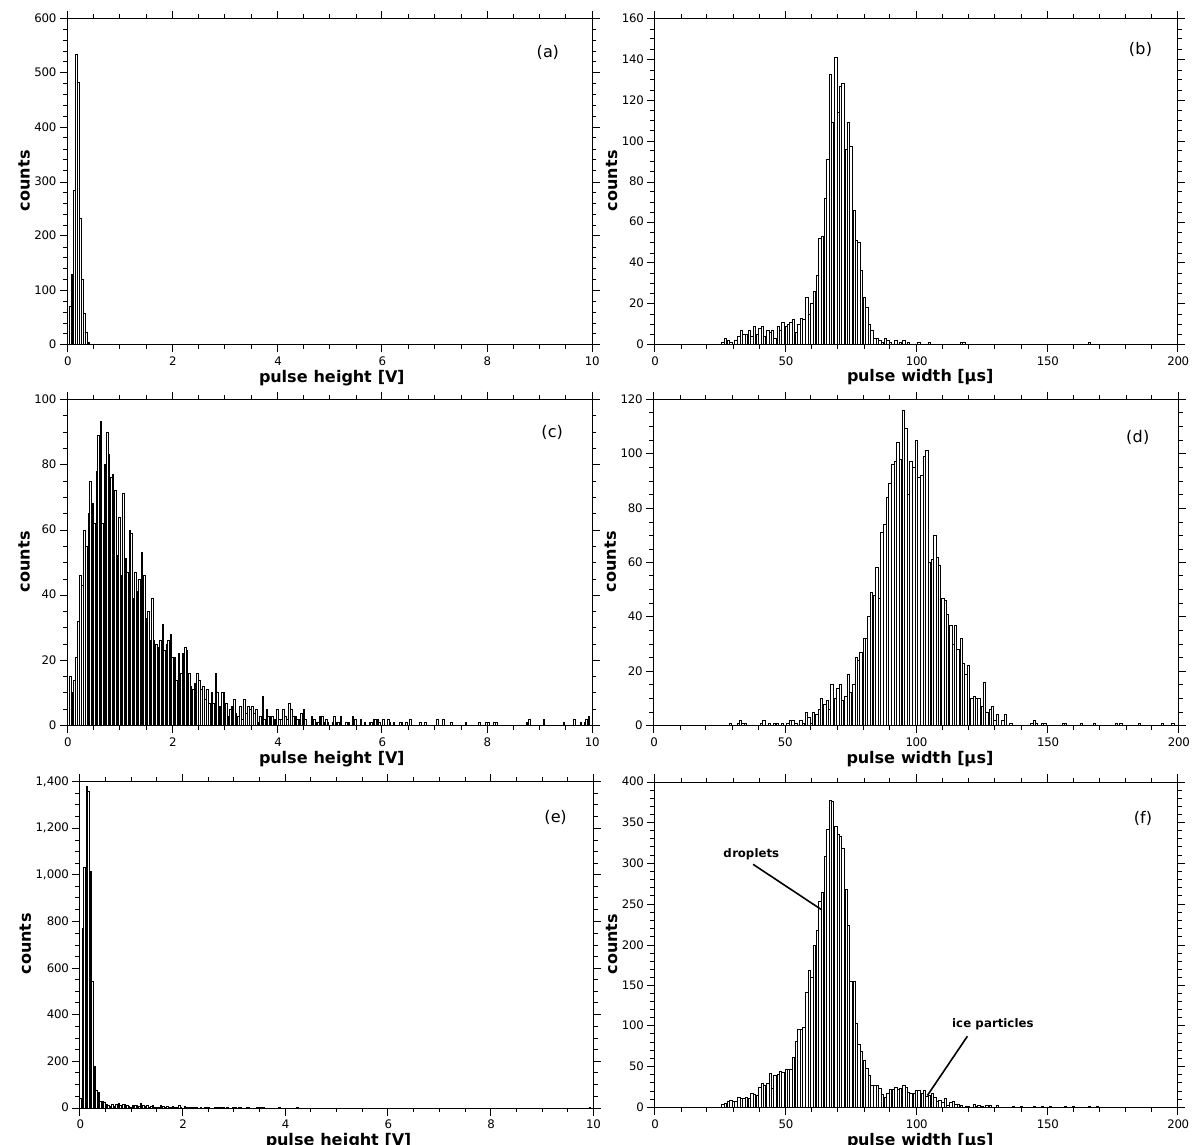
Fig. 8. Pulse height (left column) and pulse width (right column) distributions recorded by PMT C for different particle populations. Panels (a, b) show the distributions measured for the population of monodisperse droplets of approximately 2µm in diameter. Panels (c, d) show the distributions recorded for ice particles formed as a result of droplets freezing at − 40 ◦ C. Panels (e, f) show the distributions produced by a mixed particle ensemble of liquid and frozen droplets formed on 300nm Arizona Test Dust (ATD) particles at − 35 ◦ C.